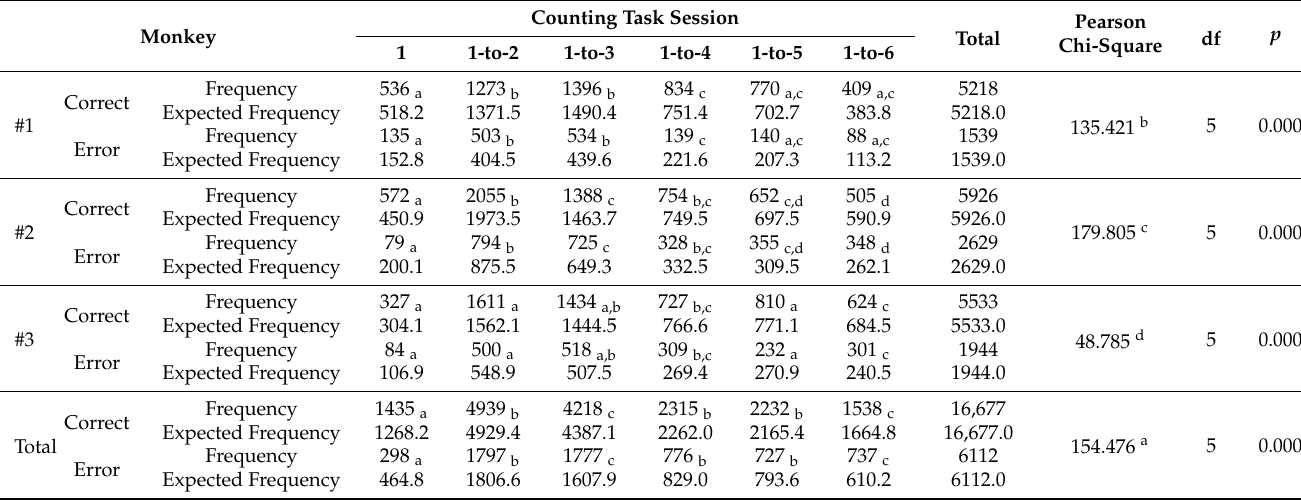
Table 1. Differences in counting task performance for different stages.